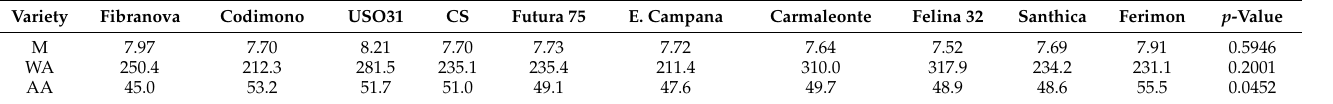
Table 1. LS means of physical properties of hemp